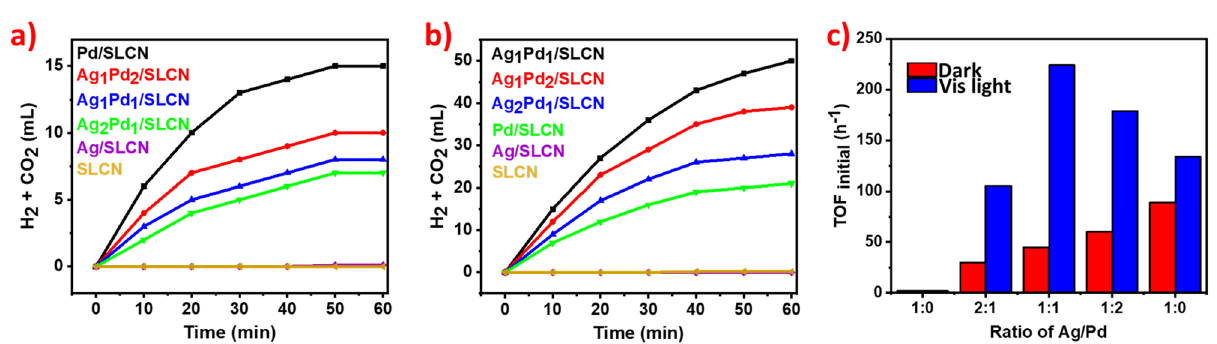
Figure 6. ( a – d ) plots of (αhυ) 2 versus hυ for bulk g-C 3 N 4 , SLCN, Ag 2 Pd 1 /SLCN and Ag 1 Pd 1 /SLCN.